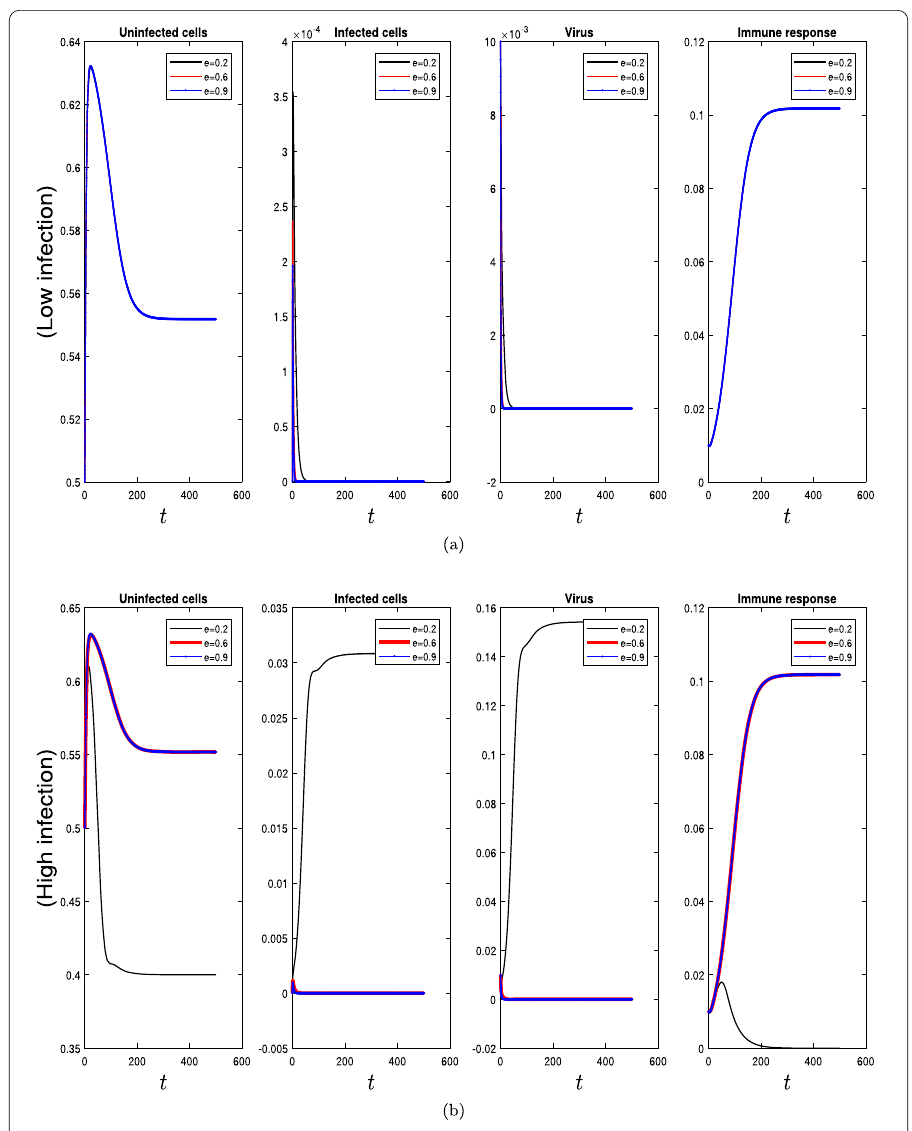
Figure 9 Numerical simulations of model (2) with initial values: x (0) = 0.5, y (0) = 0, v (0) = 0.01, and z (0) = 0.01, showing the time variation in each compartment of the model with varying values of e as shown in the legend (other parameters are set as in (11) except n = 0.16). The simulations are carried out for two cases of infection rate, ( a ) low infection ( a = 0.1) and ( b ) high infection ( a =